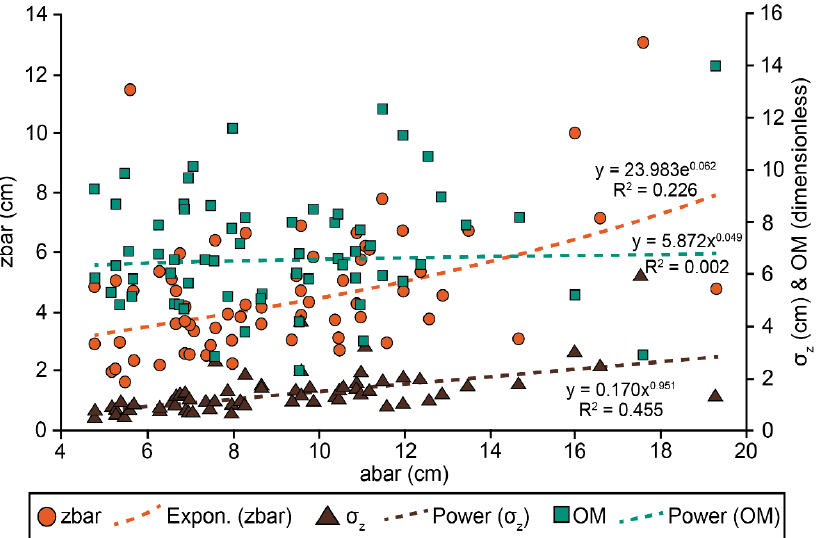
Figure 6. Comparison of abar, zbar, σ z , and organization metric (OM) values for 63 photoplots sampled and analyzed from western Prince William Sound in June 2010.